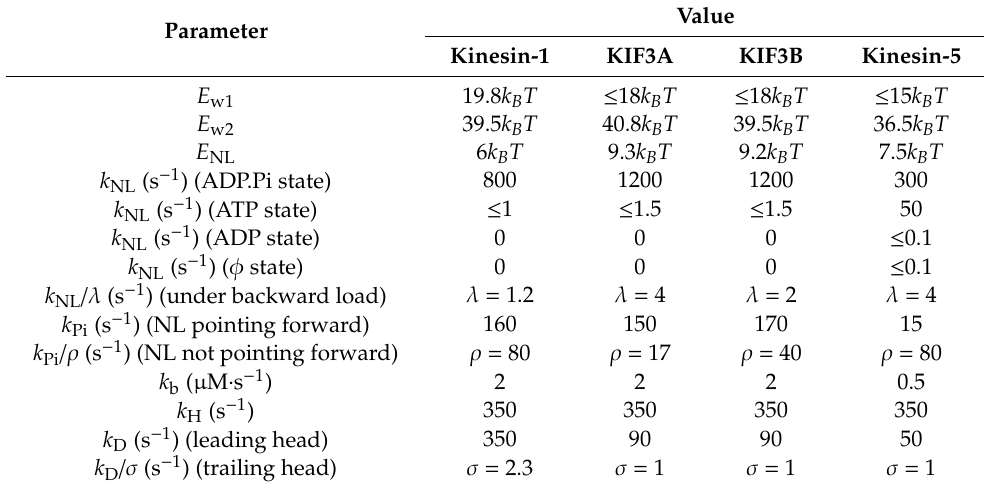
Table 1. Values of parameters used in the simulation for wild-type kinesin-1, kinesin-2 and